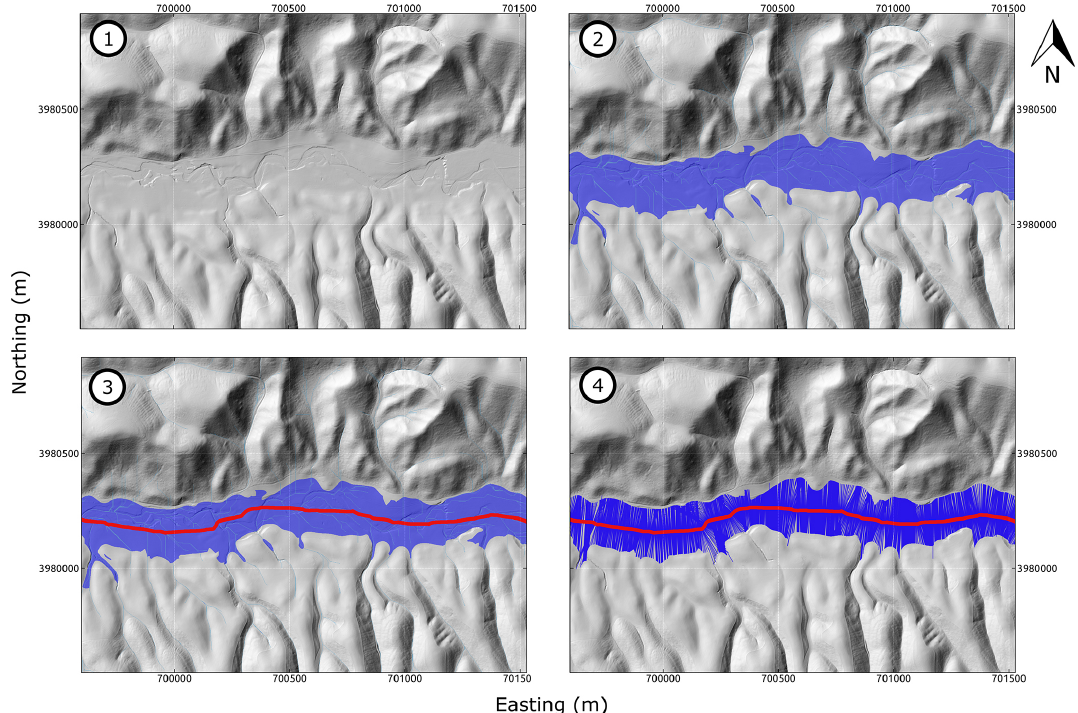
Figure 3. Step-by-step automated extraction of valley floor widths from topographic data: example from 1m lidar DTM from Gabilan Mesa, California. Coordinates are WGS84 UTM zone 10N. (1) Hillshade showing initial topographic data. (2) Identification of valleys from the DEM (Clubb et al., 2017). Dark blue pixels are identified as floodplain and light blue are identified as the channel network. (3) Extraction of valley centreline (red line). (4) Lines orthogonal to local flow direction are drawn at each point along the centreline until they reach the edge of the floodplain on either side of the valley. Width is measured for each of these lines and can be continuously plotted along the